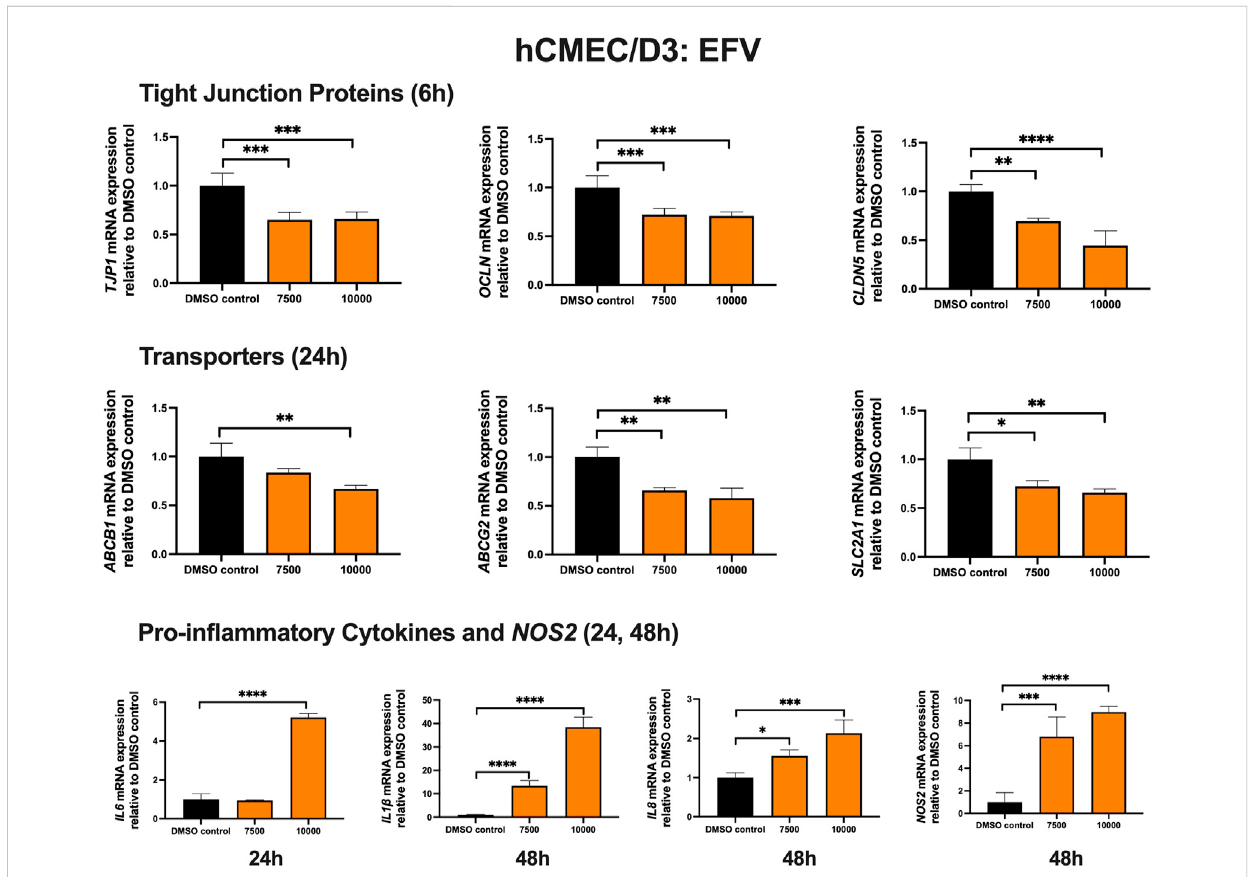
FIGURE 1 mRNA expression of TJ proteins, transporters, proin fl ammatory cytokines and NOS2 in hCMEC/D3 cells exposed to EFV (7,500, 10,000 ng/mL) or vehicle (DMSO) control for 6/24/48 h mRNA expression of TJP1, OCLN, CLDN5, ABCB1, ABCG2, SLC2A1, IL6, IL1 β , IL8 and NOS2 in hCMEC/D3 cells exposed to EFV relative to vehicle (DMSO) control was assessed by qPCR. Results are presented as mean relative mRNA expression ±SEM normalized to thehousekeepinghumancyclophilinBgenefrom n =4independentexperiments.One-wayANOVAwithBonferroni ’ spost-hoctest,*, p <